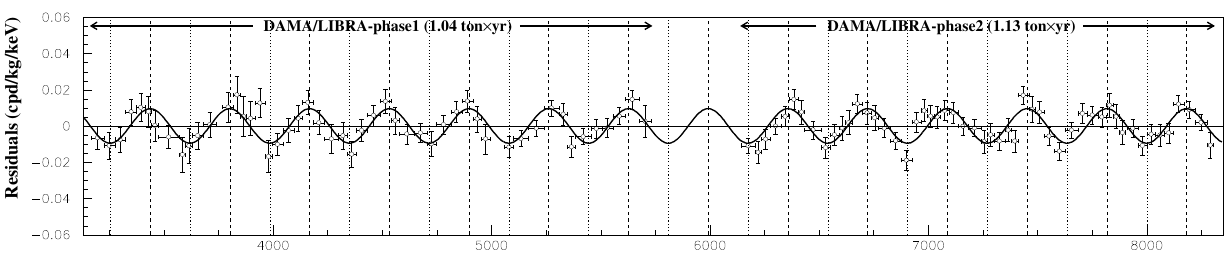
Figure 2. Residual rate for single-hit scintillation events in the (2–6) keV energy interval in DAMA/LIBRA–phase1 and DAMA/LIBRA–phase2. The shown curve is the cosinusoidal function A cos ω ( t − t 0 ) with period T = 2 π t 0 = 152.5 day (2nd June) and modulation amplitude, A , equal to the central value obtained by best fit on the data points of DAMA/LIBRA–phase1 and DAMA/LIBRA–phase2. Other residual rates for different energy regions and, in particular, with lower energy threshold of 1 keV are reported in Refs. [7,23,31]. Reprinted with permission from [31]. Creative Commons License CC BY